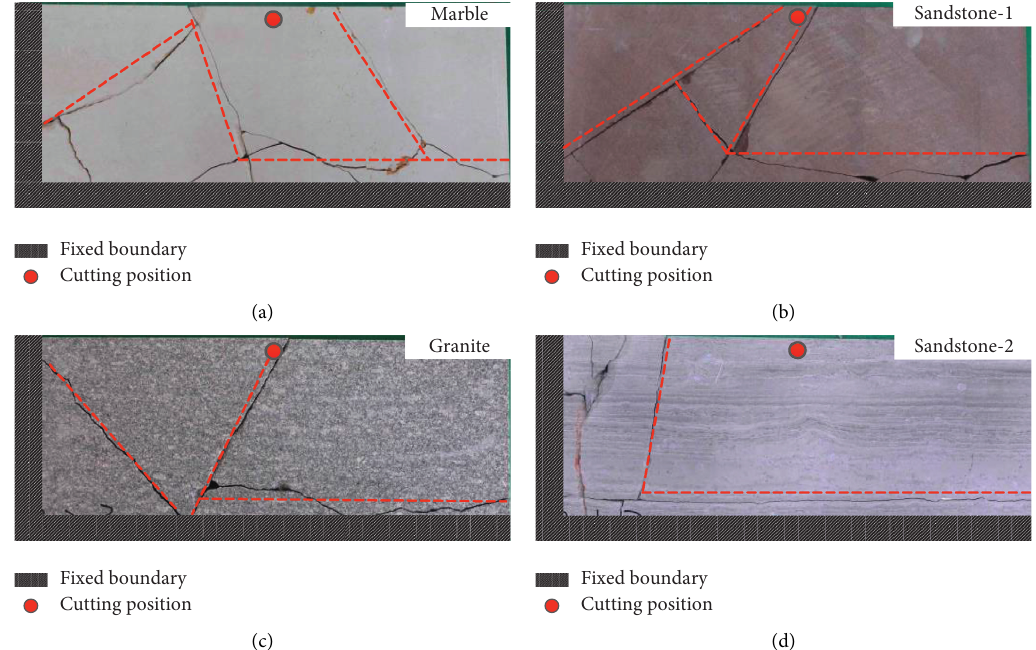
Figure 12: The cutting results of rock with different UCS. (a) Marble. (b) Sandstone-1. (c) Granite. (d) Sandstone-2.